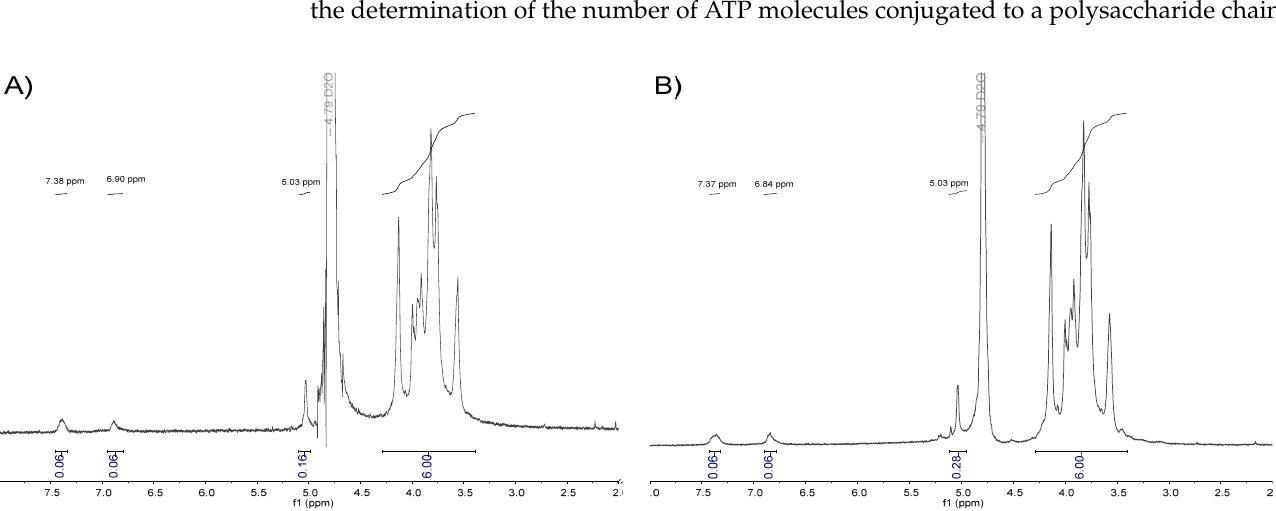
10:90), the M n of the hydrolyzed fibers, and the relative peak area of aromatic pro- tons (cid:1516) GM HCl/ox/ATP = 0.06 and (cid:1516) GM Enz/ox/ATP = 0.07, it was possible to calculate the number of ATP molecules per polymer chain (n°(ATP)) based on Equation (1). Specifically, it was found that n°(ATP) GM HCl/ox/ATP = 2.1 and n°(ATP) GM Enz/ox/ATP = 1.7, which is the same general trend as the number of carbonyl groups per polymer chain as previously calcu- lated for the oxidized substrates used for the labelling (Table 2). 3.2. Characterization of Citrate-AuNPs and Glyco-AuNPs 3.2.1. UV–Vis Absorption, DLS, and TEM Analysis of Citrate-AuNPs Citrate gold nanoparticles were synthetized through reduction of Au 3+ to Au 0 by tri- sodium citrate. Individual replicates of the UV–Visible spectrum of the resultant nanopar- ticles are shown in Figure 6A, where in all the measured samples, the characteristic gold surface plasmon resonance absorption band ( λ (SPR) ) was observed at 524 nm, confirming the synthesis of nanoparticles. Moreover, dynamic light scattering (DLS) and zeta potential measurements ( ζ ) were performed to investigate the hydrodynamic diameter ( d h ) and surface charge of the citrate- capped AuNPs, respectively. The mean hydrodynamic size of the colloid sample was d h = 30.1 ± 0.5 nm (Figure 6B) and the zeta potential was ζ = − 37.2 ± 0.5 mV, suggesting an efficient stabilization of the particles with negative charges on the surface, in accordance with anionic citrate caps on the AuNP surface [35]. In addition, the average particle size ( d ) and morphology were determined by TEM (Figure 6C). Sphere-like gold nanoparticles were produced, however, the particles had a broad range of sizes in the colloidal solution with an average size of 18.3 ± 9.4 nm (Figure 6D). This broad particle size distribution can be a consequence of the initial concentration of sodium citrate added into the reaction mixture. Kumar and Meenan reported that the Au/citrate molar ratio was the parameter that had a significant effect on the dispersity of the particle solution [36]. In particular, a lower amount of citrate led to a wider distribu- tion and larger average size. According to the authors and considering that the polydis- persity index (0 ≤ PdI ≤ 1) measures the broadness of the size distribution where values close to 1 indicate that the distribution is highly polydisperse, an average dispersity value of PdI = 0.48 was obtained when the Au/citrate molar ratio increased from 0.09 (PdI = 0.25)